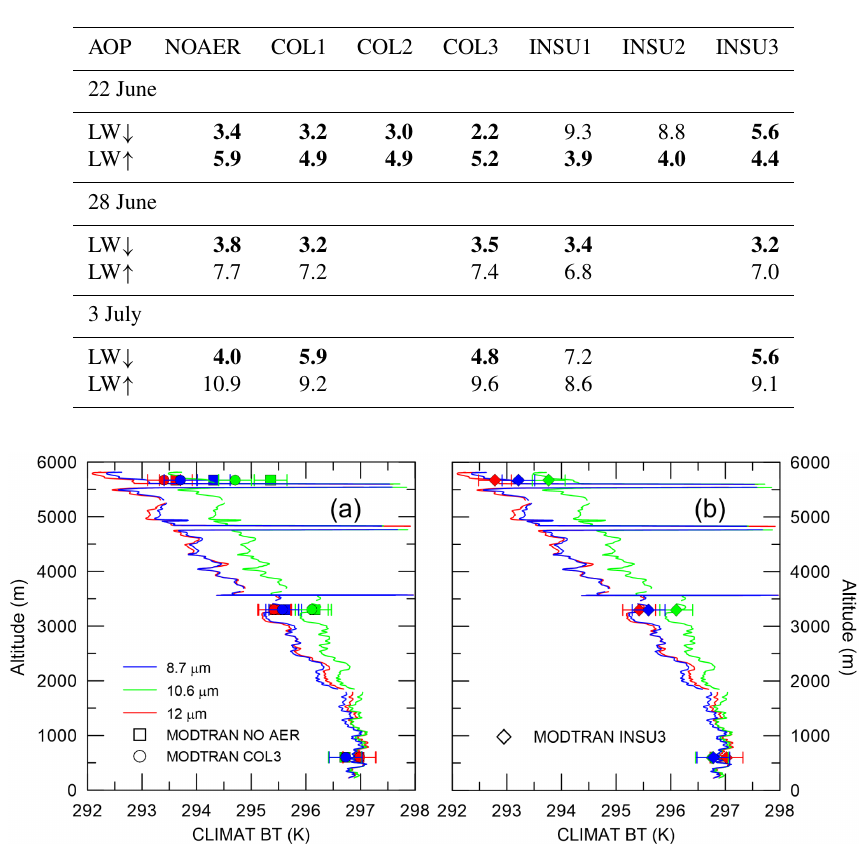
Table 4. RMSD (inWm − 2 ) between modelled and measured downward and upward LW irradiances for the ATR-42 profiles in the three analysed cases. Model calculations are made with different AOPs. The measurement uncertainty is ± 6Wm − 2 . Values within the measure- ment uncertainty are in bold.